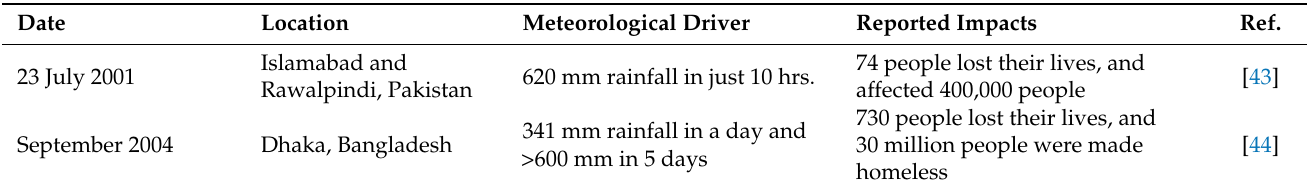
Table 1. Major Urban Flood events in South Asian Cities.